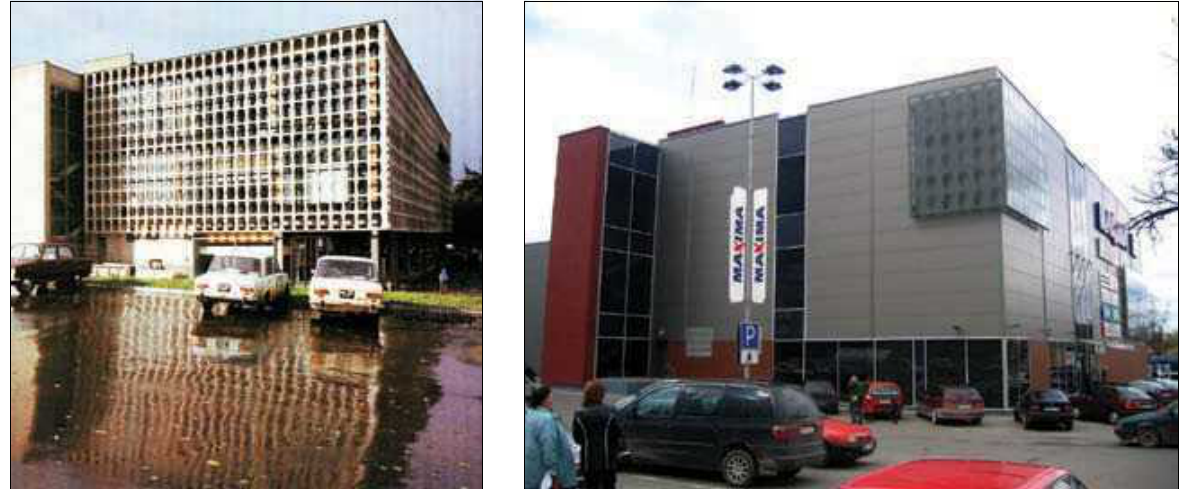
13, 14 pav. baldų pardu­otu­vė „klevas“ Panevėžyje (arch. N. Grabliau­skienė) 1970 m. ir dabar (13 pav. paimtas iš L. Skrebė. Panevėžys . Vilniu­s: Mintis, 1984; 14 pav. nu­otrau­ka I. r­ačkau­sko) Figs. 13, 14. Fu­rnitu­re Store “klevas” in Panevėžys (arch. N. Grabliau­skienė) in 1970 and